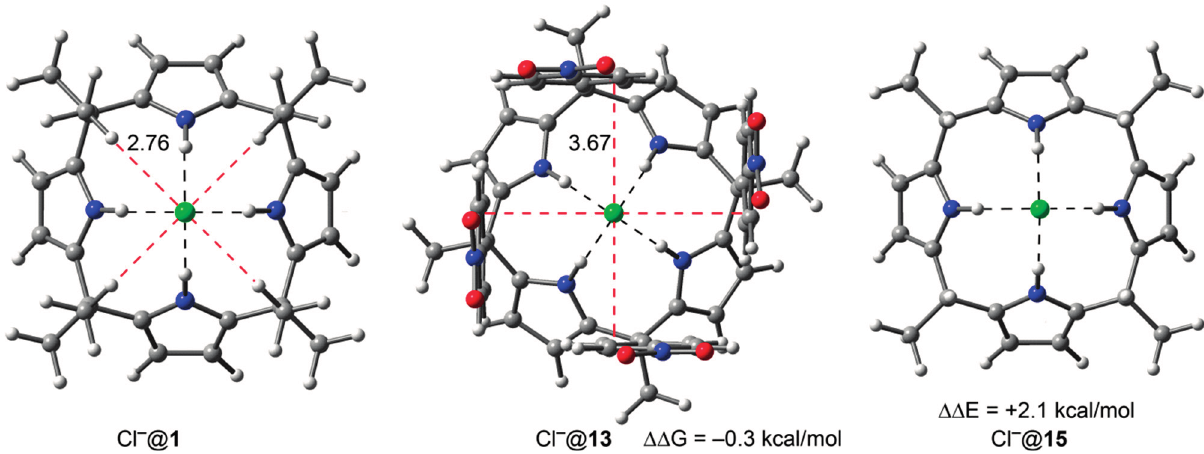
Figure 5. DFT energy optimized chloride complexes with receptors 1 , 13 and 15 . Distances in Å. The CH···Cl − and anion– π interactions are indicated using red dashed